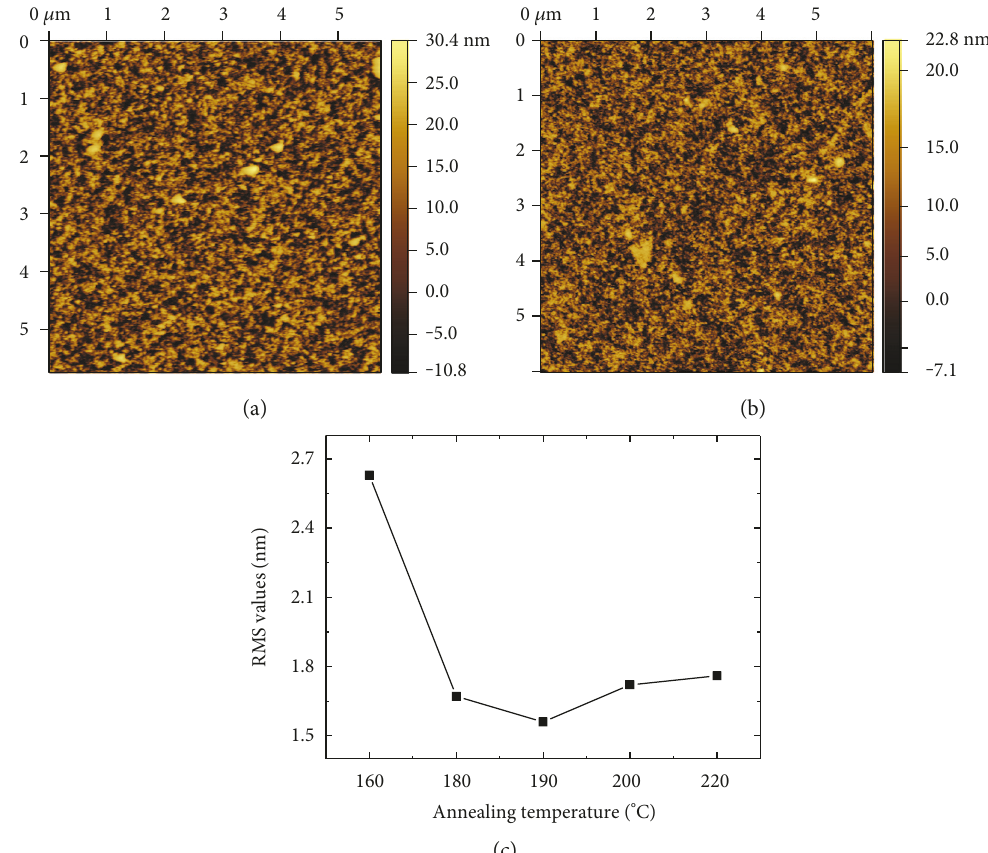
Figure 4: AFM images of PEDOT:PSS fi lms annealed at (a) 160 ° C and (b) 190 ° C. (c) RMS value variation of PEDOT:PSS fi lms with the di ff erent annealing temperatures.